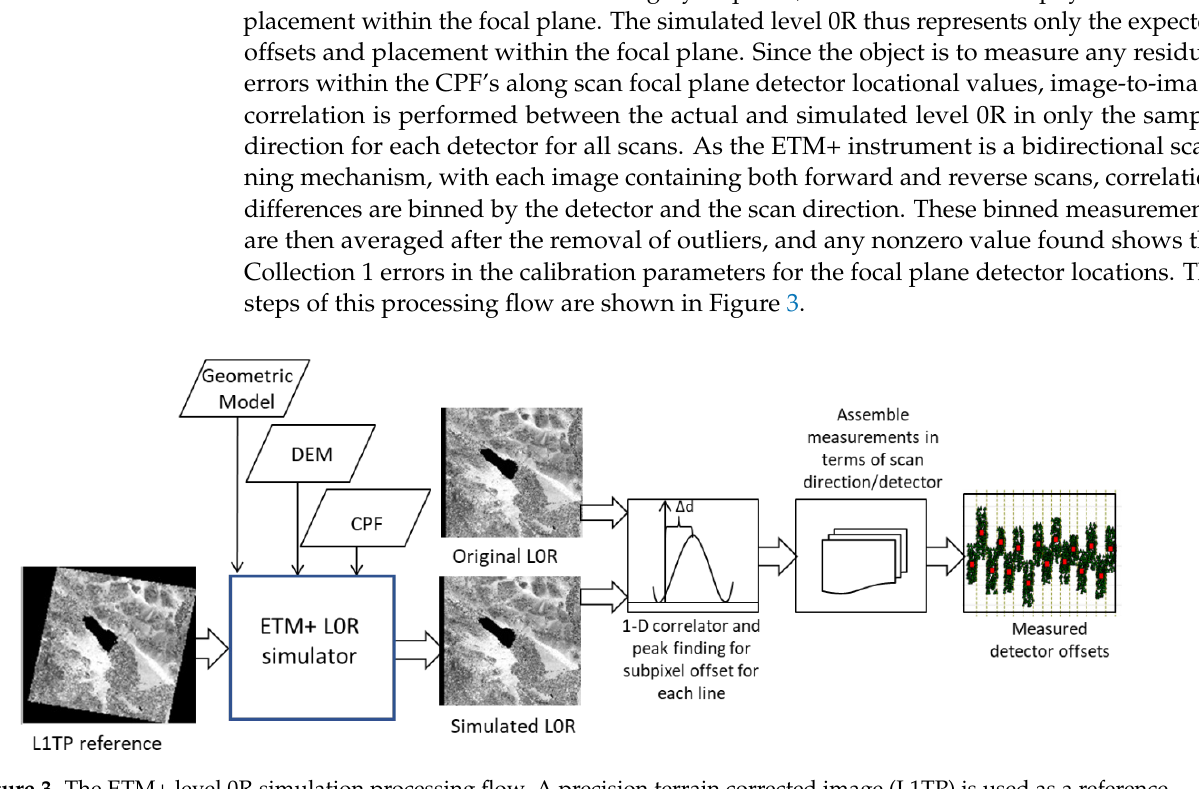
Figure 3. The ETM+ level 0R simulation processing flow. A precision terrain corrected image (L1TP) is used as a reference, and its pixels are mapped back into a geometrically raw image space creating a file that represents a geometrically untouched, by any resampling, state of the data acquired during an orbit acquisition. A geometric model defining the mapping between geographic latitude and longitude and a raw geometric pixel, a digital elevation model (DEM), and a set of calibration parameters (CP) files are needed for determining the mapping between pixels. The misregistration between the simulated image and the actual image (level 0R) determines any detector-to-detector misalignment that would be present in the data product